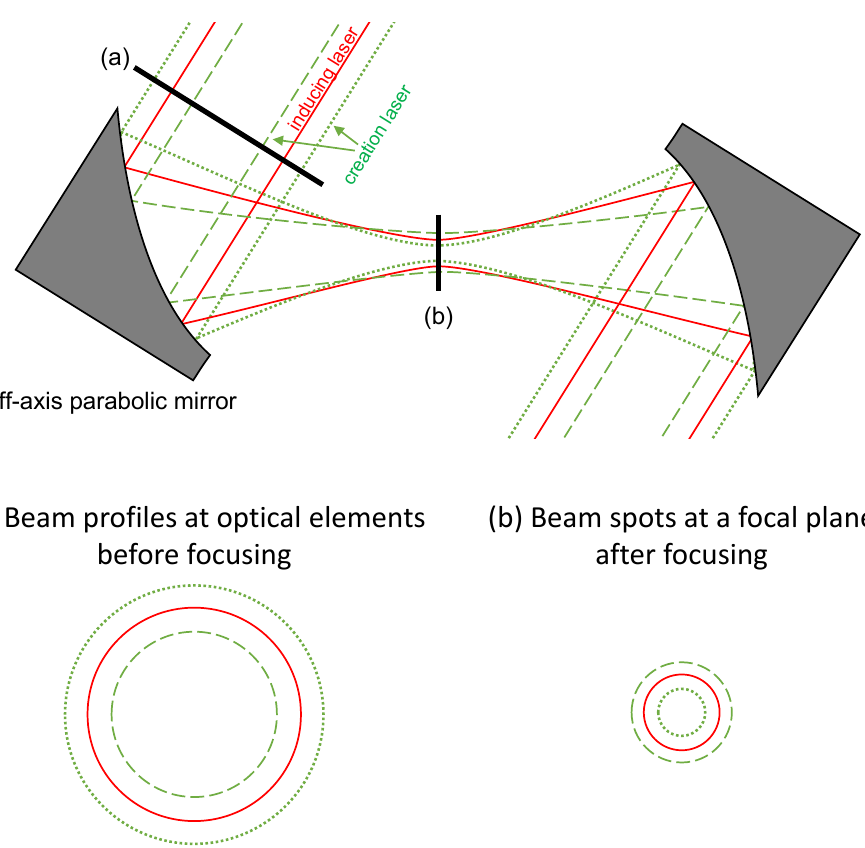
Figure 3 . Relations between beam cross sections for creation and inducing lasers: (a) at planes in optical elements before focusing and (b) at the focal plane after focusing. (a) The creation and inducing laser cross sections are drawn with dotted and dashed green lines and a solid red line, respectively. The optical-element aFWM photons are produced at the overlapping areas between the cross sections of the creation and inducing beams. (b) Behavior of the two beams at a focal plane after focusing is illustrated. Since the beam waist is proportional to the inverse of the beam diameter at the focal point, a large (small) creation beam diameter makes the beam waist small (large) and the beam intensity higher (lower). Photons from vFWM and residual-gas-originating aFWM can be generated from the overlapping areas between the two beam cross sections, while optical-element aFWM photons are never